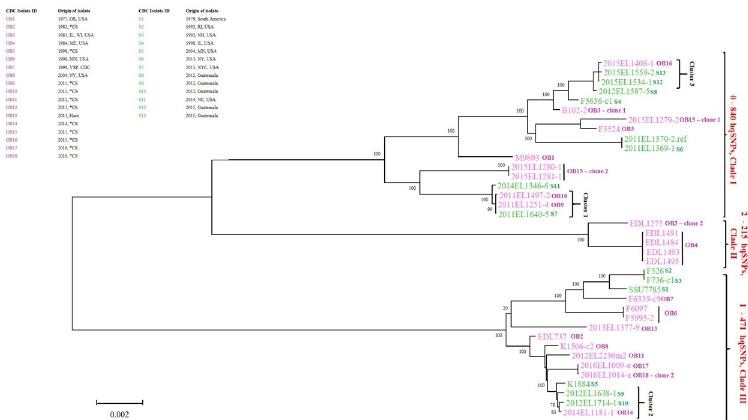
Fig 1. ETEC O6 isolates are clustered into three clades by whole genome high-quality SNP analysis. Whole genome high-quality single nucleotide polymorphisms (WG-hqSNP) tree generated by Lyve-SET for phylogenetic relatedness of 37 ETEC O6 isolates against the reference genome 2011EL1370-2. The scale represents a distance of 0.002 hqSNPs per site. At each ancestor node, bootstrap percentages are displayed. Isolates are clustered into Clade I, Clade II and Clade III. Isolates are color coded based on isolation during an outbreak (OB) or sporadic infection (S). In the metadata table, � CS stands for Cruise Ship; US states are abbreviated.